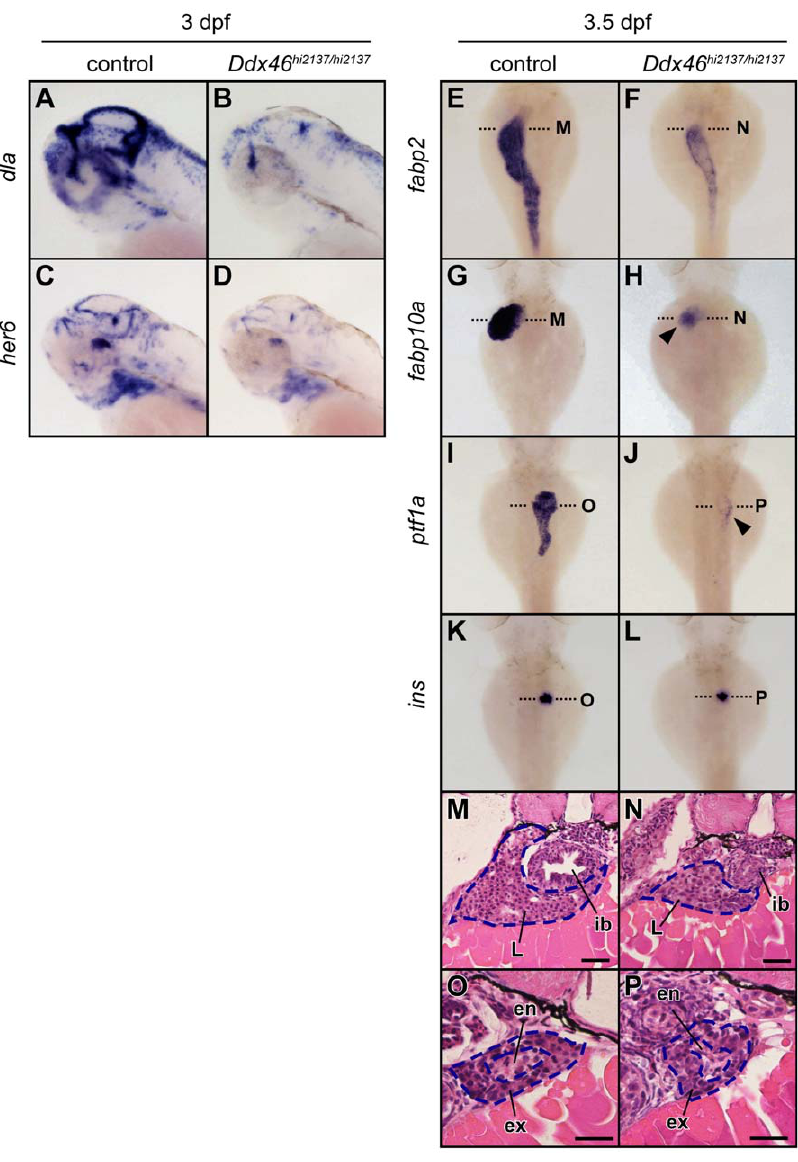
Figure 5. Expression of molecular markers for digestive organs and brain is reduced in the Ddx46 hi2137/hi2137 mutant. (A–D) The expression of dla and her6 was examined using whole-mount in situ hybridization at 3 dpf. All lateral views, anterior to the left. (E–L) The expression of fabp2 , fabp10a , ptf1a , and ins was examined using whole-mount in situ hybridization at 3.5 dpf. All dorsal views, anterior to the top. In the Ddx46 hi2137/hi2137 mutants, the intensity and area of dla , her6 , fabp2 , fabp10a , and ptf1a expression were markedly reduced at 3 or 3.5 dpf (A–J; arrowheads in H, J). In contrast, the ins expression in the Ddx46 hi2137/hi2137 mutant did not change at these developmental stages (K, L). (M–P) Transverse sections of 3.5-dpf Ddx46 hi2137/hi2137 mutant larvae stained with hematoxylin and eosin. The transverse sections were cut at the levels indicated by black dotted lines in E–L. The tissues in the intestinal bulb, liver, and exocrine pancreas were still present in the Ddx46 hi2137/hi2137 mutant larvae at 3.5 dpf. Scale bars, 50 m m. en, endocrine pancreas; ex, exocrine pancreas; ib, intestinal bulb; L, liver. Control larvae were sibling WT or Ddx46 hi2137/ + larvae and had normal phenotypes.